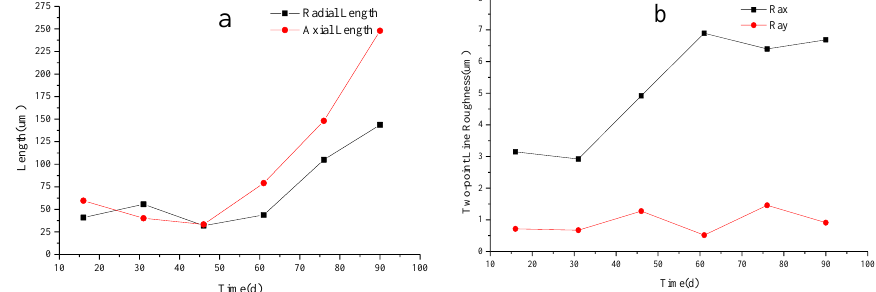
Figure 12. Measurement site of the wheat stalk at different times with plowing tillage. Note: ( a ), ( b ), ( c ), ( d ), ( e ), ( f ) — 2, 3, 4, 5, 6, 7 samplings with plowing tillage.